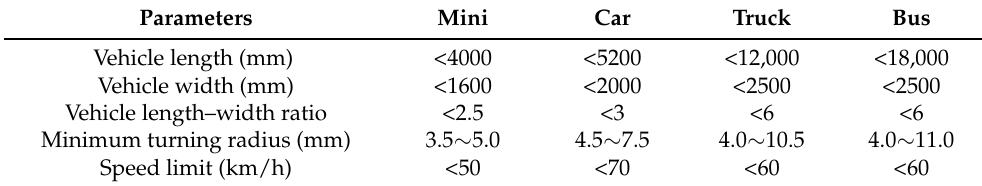
Table 2. Main parameters of vehicles. Parameters Mini Car Truck